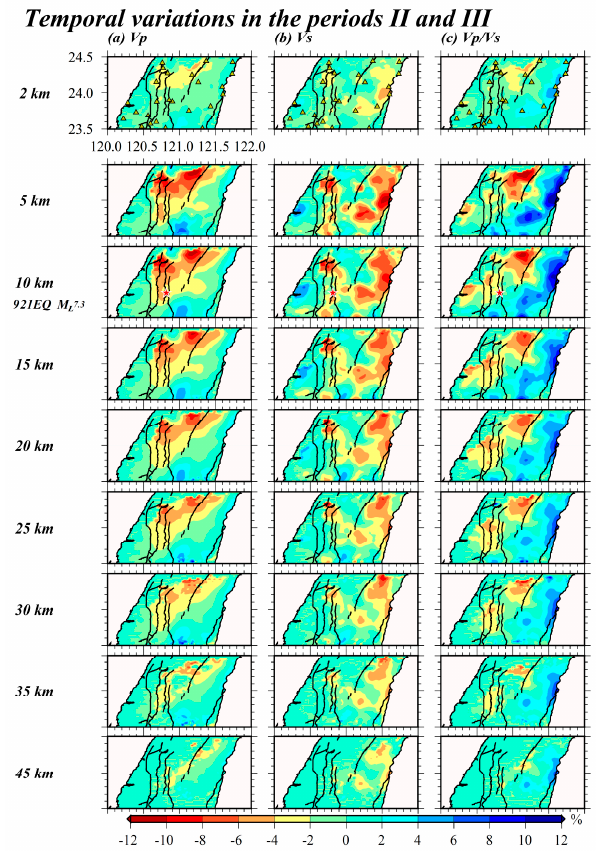
Figure 11. ( a ) Temporal variation in Vp in the periods II and III. ( b ) Temporal variation in Vs in the periods II and III. ( c ) Temporal variation in Vp/Vs in the periods II and III. See the detail description in the text.